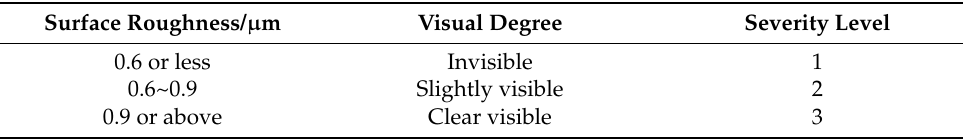
Figure 8. Height contour of the sample surface. Table 3. Severity grade of skid lines.